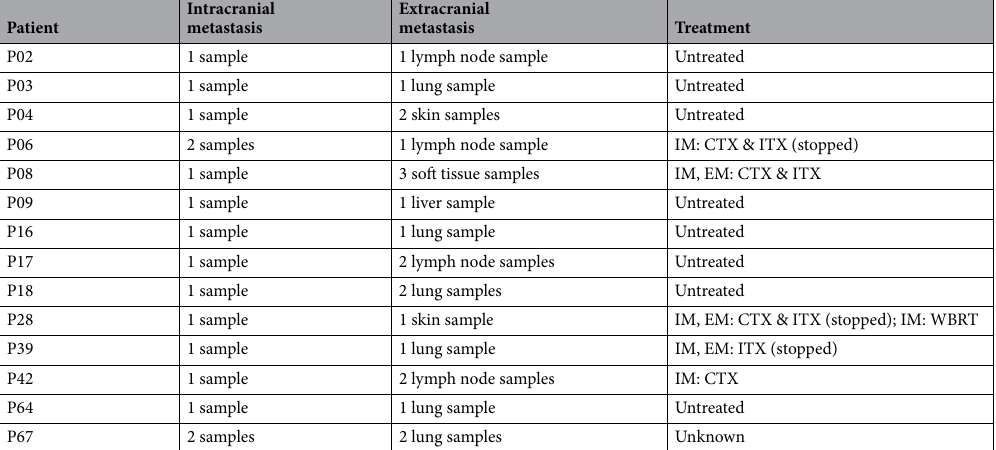
Table 1. Patient and sample overview. Each patient developed an intracranial metastasis and an extracranial metastasis in either lung, lymph node, skin, liver or soft tissue. Multiple samples of the same metastasis were taken if they showed histologically different regions. The treatment column provides information if and how a patient was treated before the surgical removal of a metastasis. IM Intracranial metastasis, EM Extracranial metastasis, CTX Chemotherapy, ITX Immunotherapy, WBRT Whole brain radiotherapy. Treatment of three patients was stopped at least one month before surgery. Metastases of P67 were obtained post mortem.